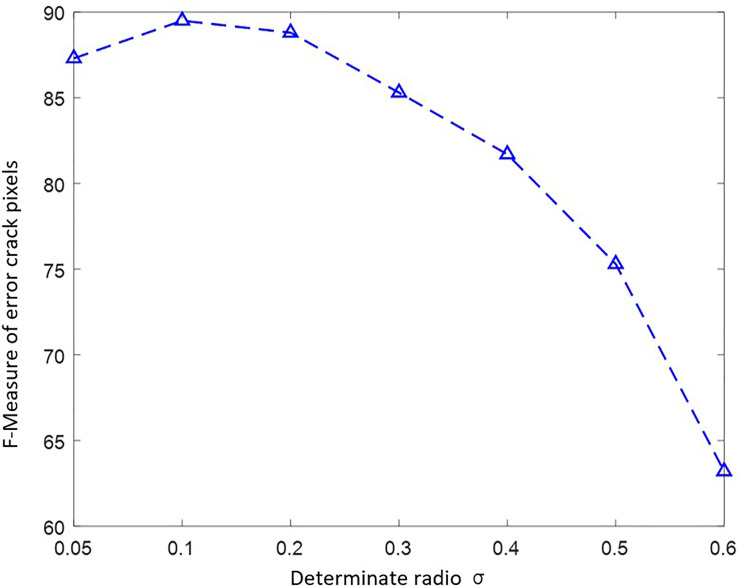
F-Measure of error crack pixels for different determinate radio.